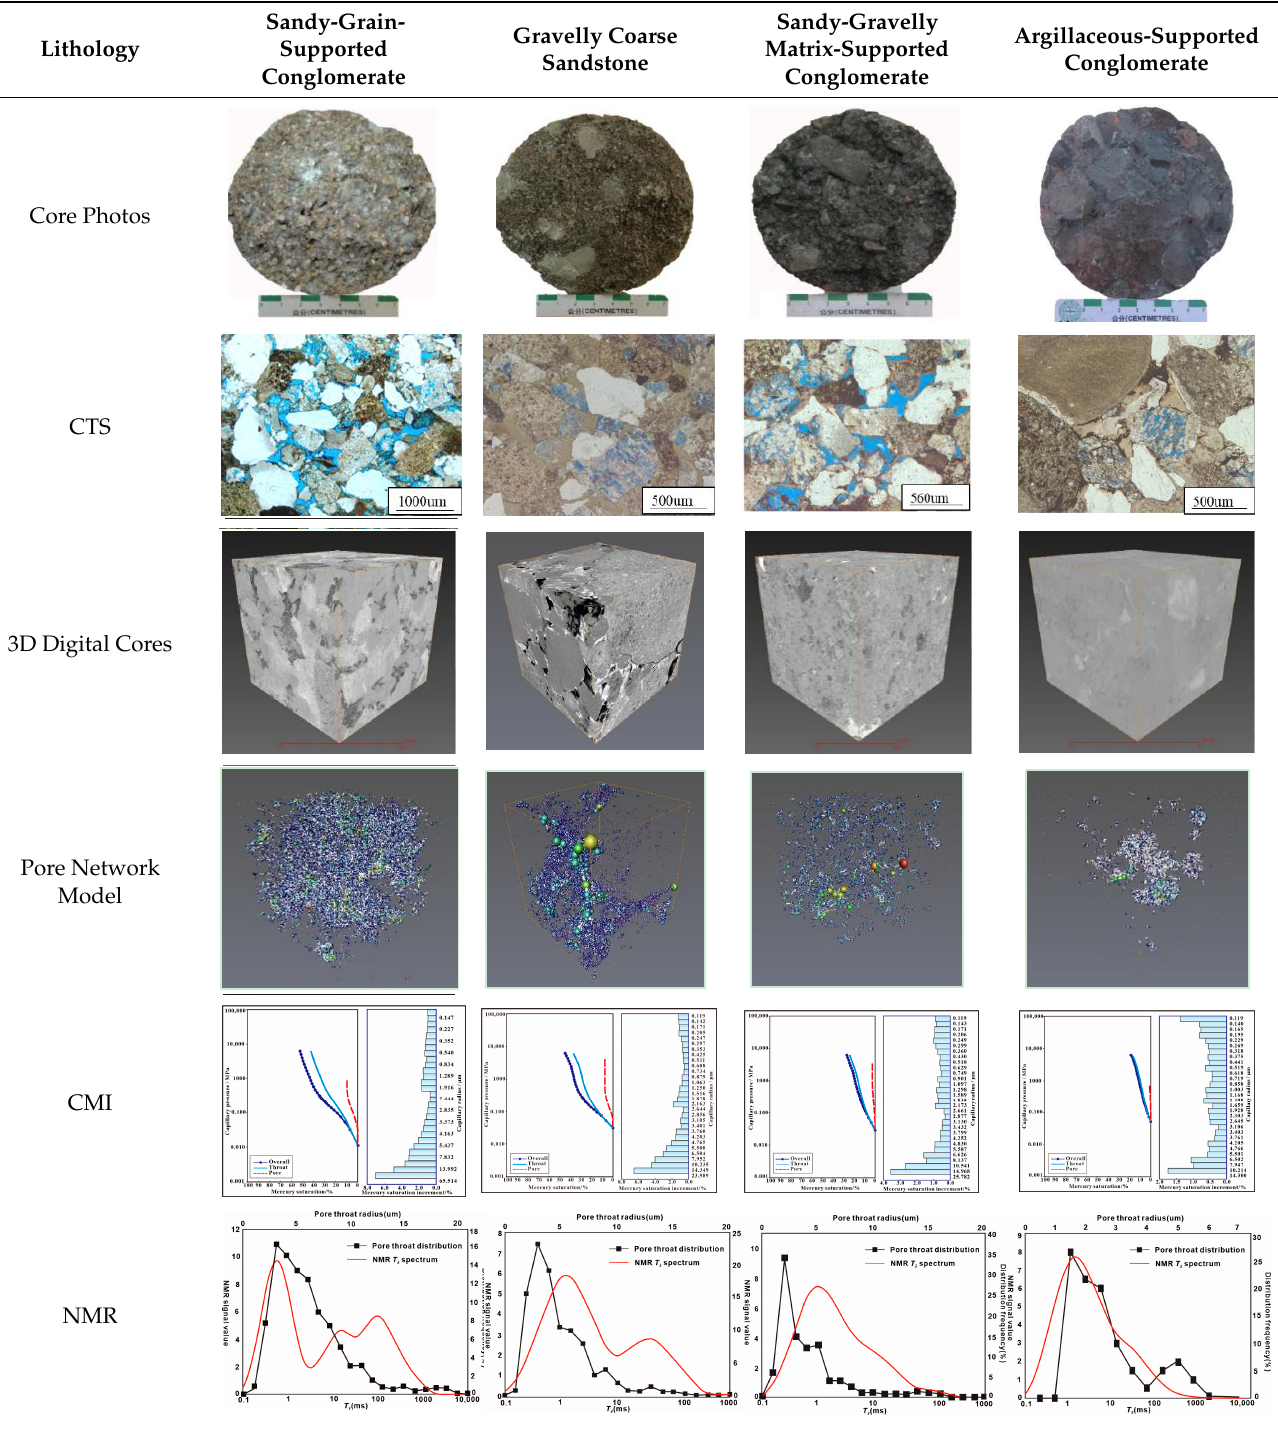
Table 2. Microscopic pore structure characteristics of low permeability conglomerate samples with different lithologies.